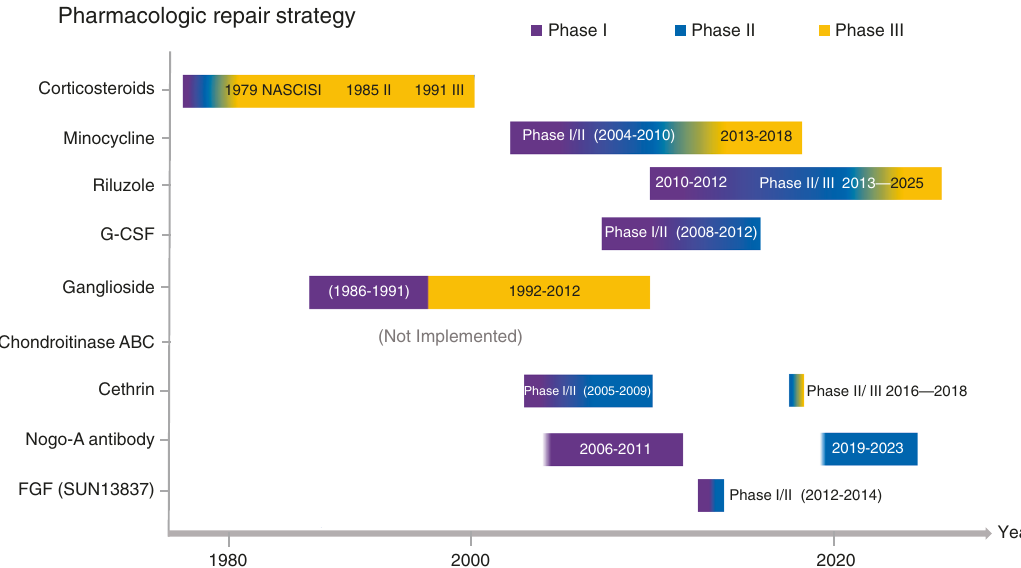
Fig. 5 Research progress on pharmacological strategies for repairing the injured spinal cord. This fi gure shows clinical trials on medicines for the treatment of SCI, including corticosteroids, minocycline, riluzole, G-CSF, ganglioside, chondroitinase ABC, cethrin, Nogo-A antibodies, and FGF